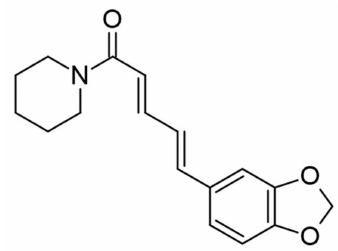
Figure 6. Chemical structure of